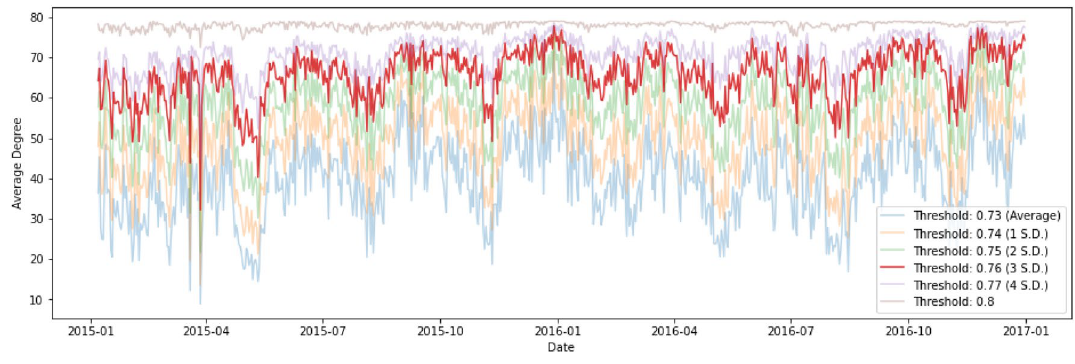
Figure 11. Threshold sensitivity for the period of 2015 to